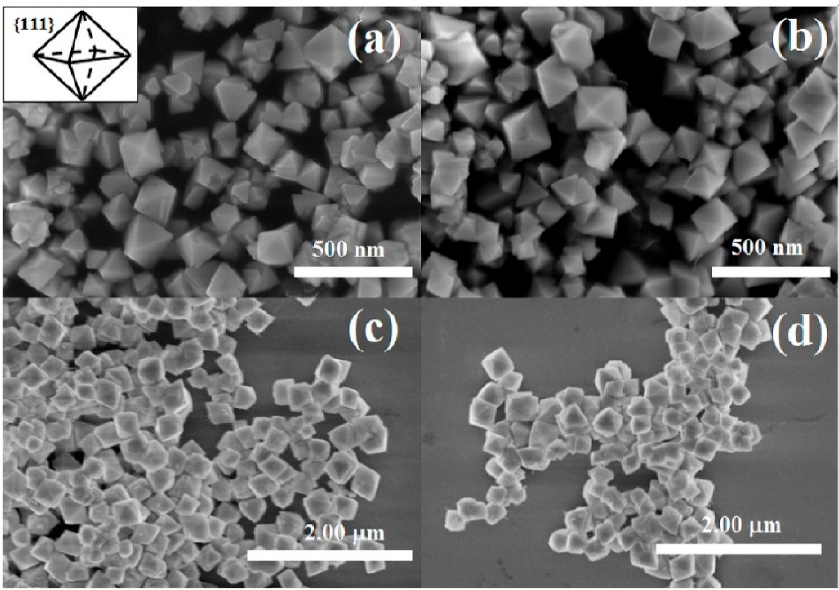
Figure 15. Octahedra of Er-CeO 2 prepared using Na 3 PO 4 ·12H 2 O as an additive in hydrothermal crystallisation ( a ), CeO 2 : 3 mol% Er 3+ , 10 mol% Li + ( b ) and the SEM images of the above nanocrystals with post-calcination temperatures of 800 °C ( c , d ) [118]. Reprinted from Yang, Y.; Cong, Y.; Dong, D. P.; Xiao, Y.; Shang, J.Y.; Tong, Y.; Zhang, H.M.; He, M.; Zhang, J.H. Structural and excitation dependent emission properties of octahedral CeO 2 :Er 3+ nanocrystal. J. Lumin. 2019 , 213 , 427–432, with permission from Elsevier.